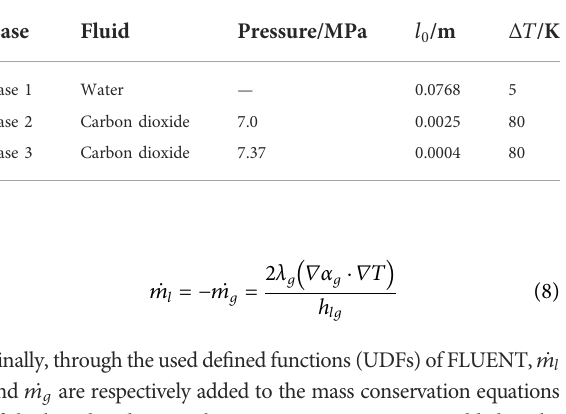
TABLE 1 Numerical simulation cases.